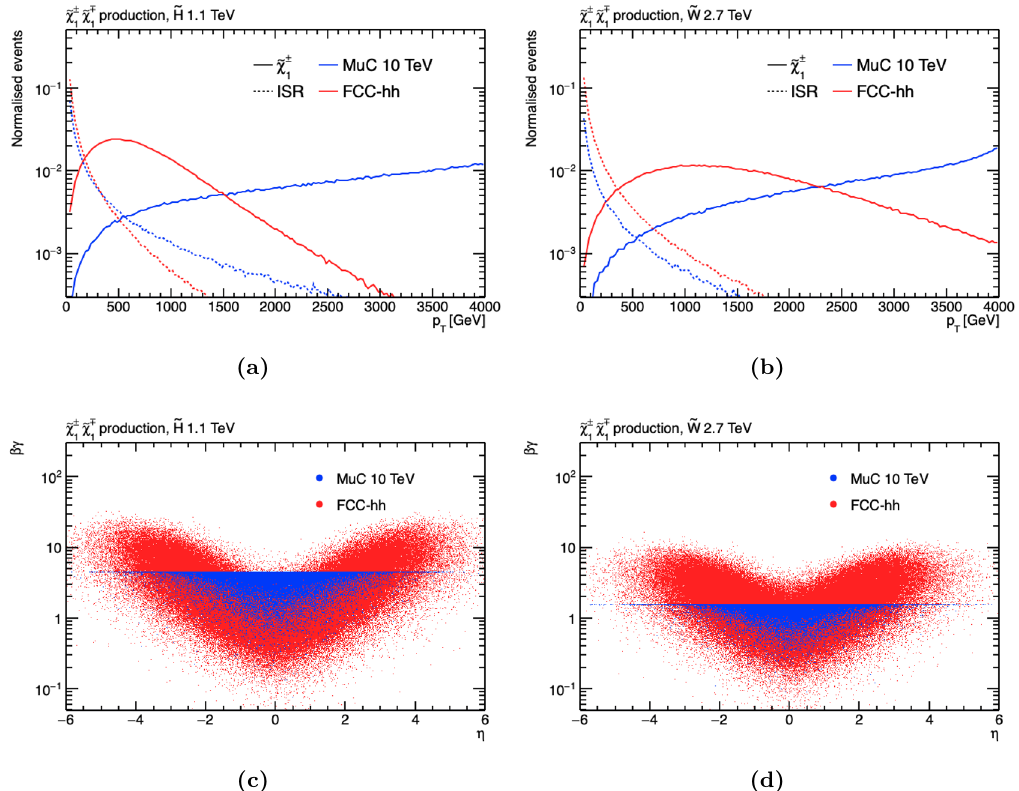
Figure 2. Kinematic distributions for thermal higgsino, m χ = 1 . 1 TeV (left) and thermal wino, √ m χ = 2 . 7 TeV (right) at a putative Muon Collider with s = 10 TeV and at a proton-proton √ collider with s = 100 TeV. The upper panel shows the p T of the chargino (solid line) and of the corresponding initial state radiation particle (jet for FCC-hh, photon for MuC) with dashed lines. The lower panel shows the distribution of the events in the η − βγ plane, using red (blue) for the FCC-hh